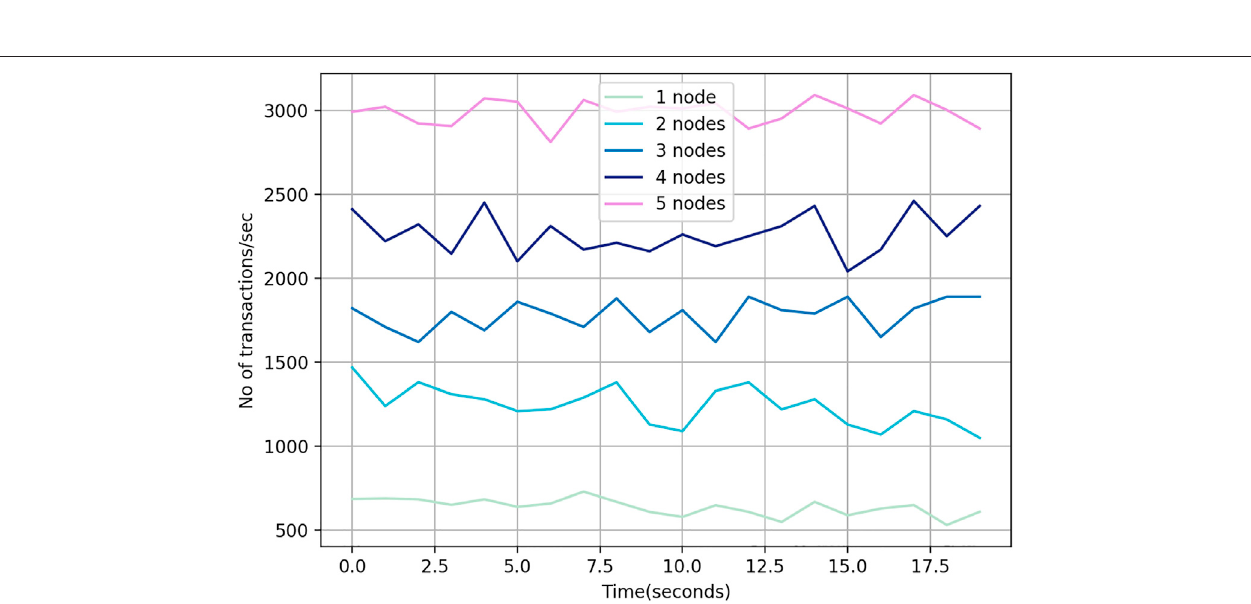
FIGURE 9 | Transaction execution rate comparison with a number of blockchain nodes in the Vind blockchain.